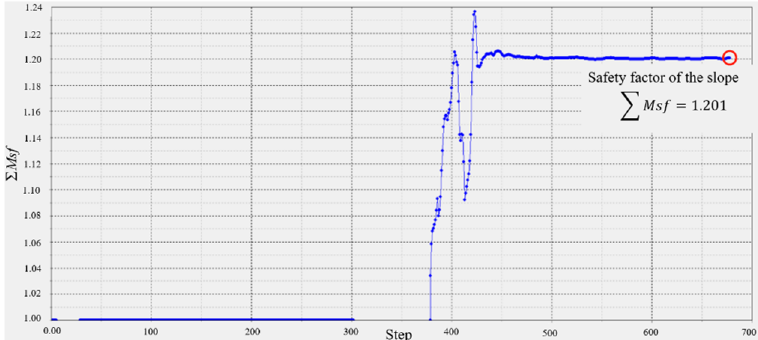
Figure 15. Slope safety factor.